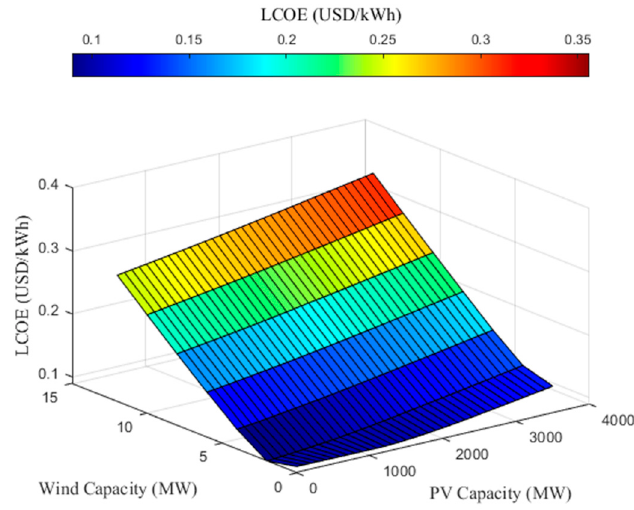
Figure 3. The levelized cost of electricity (LCOE) of different PV/wind hybrid system sizes in Gwanda. Table 2 . The maximum feasible wind, PV and PV-wind hybrid systems capacities in Gwanda, Zimbabwe, in addition to their economic and technical parameters.